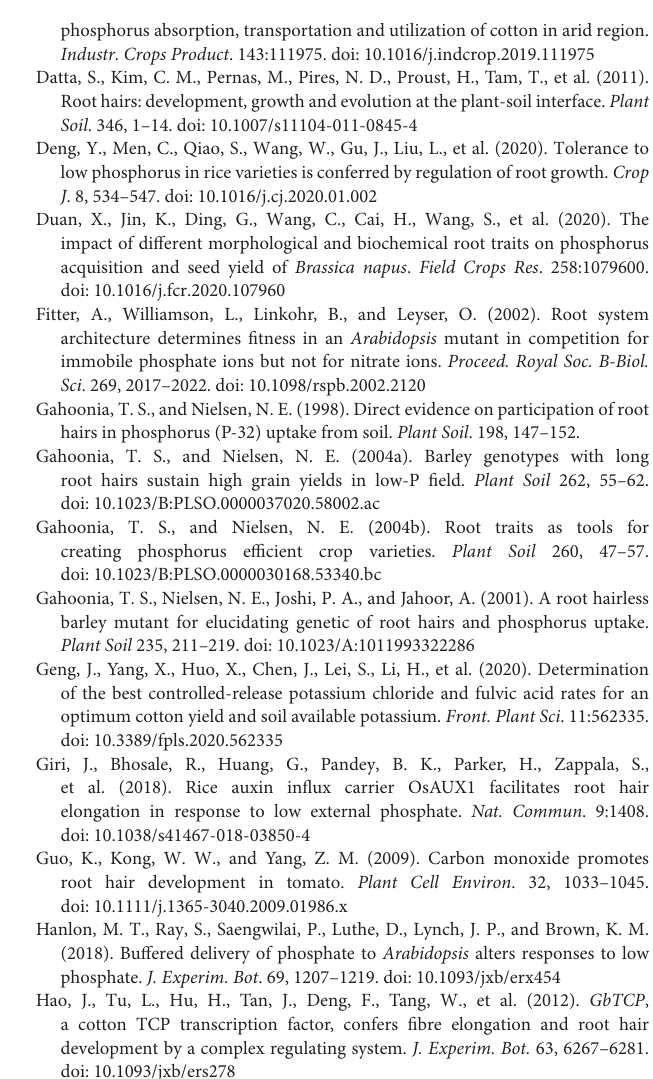
Supplementary Figure 1 | Image of cotton plant phenotypes under different phosphorus treatments. On the left side of (A) is “Nongdamian No. 10” cultivar under replete phosphorus conditions (ND-PR) and on the right side is “Nongdamian No. 10” cultivar under low phosphorus (ND-PD). On the left side of (B) is “Jimian 315” cultivar under replete phosphorus conditions (JM-PR) and on the right side is “Jimian 315” cultivar under low phosphorus